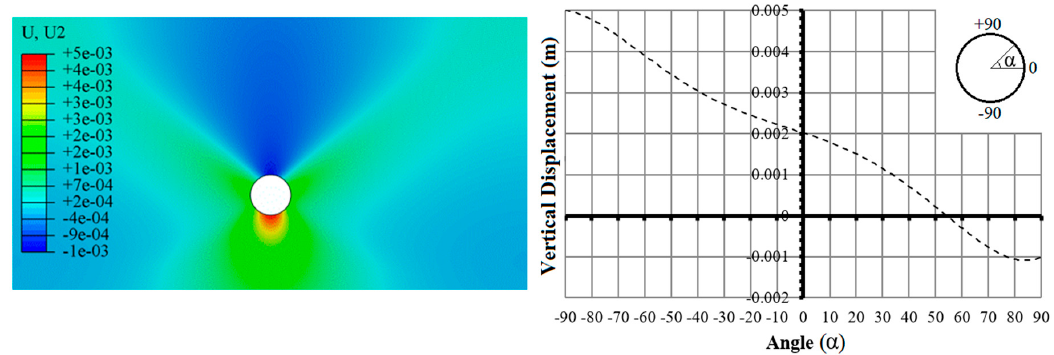
Figure 7. Convergence of the model for all scenarios.